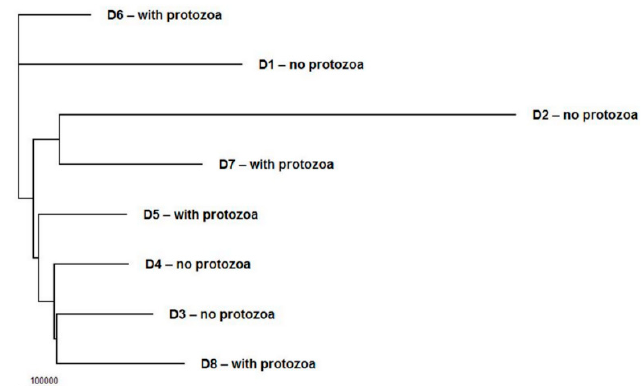
Figure 1. Dendrogram depicting the relationship of bacterial diversity between samples from roe deer ( Caprelous caprelous ) with rumen protozoa (D1–D4) or without protozoa (D5–D8). Table 1. Comparison of protozoa numbers ( × 10 5 / mL rumen fluid) and hydrolytic activities ( µ M of released monosaccharide / g dry matter of content per minute) in the rumen of roe deer ( Caprelous caprelous ) with protozoa and without protozoa. Item Total protozoa ( Entodinium spp.) 1